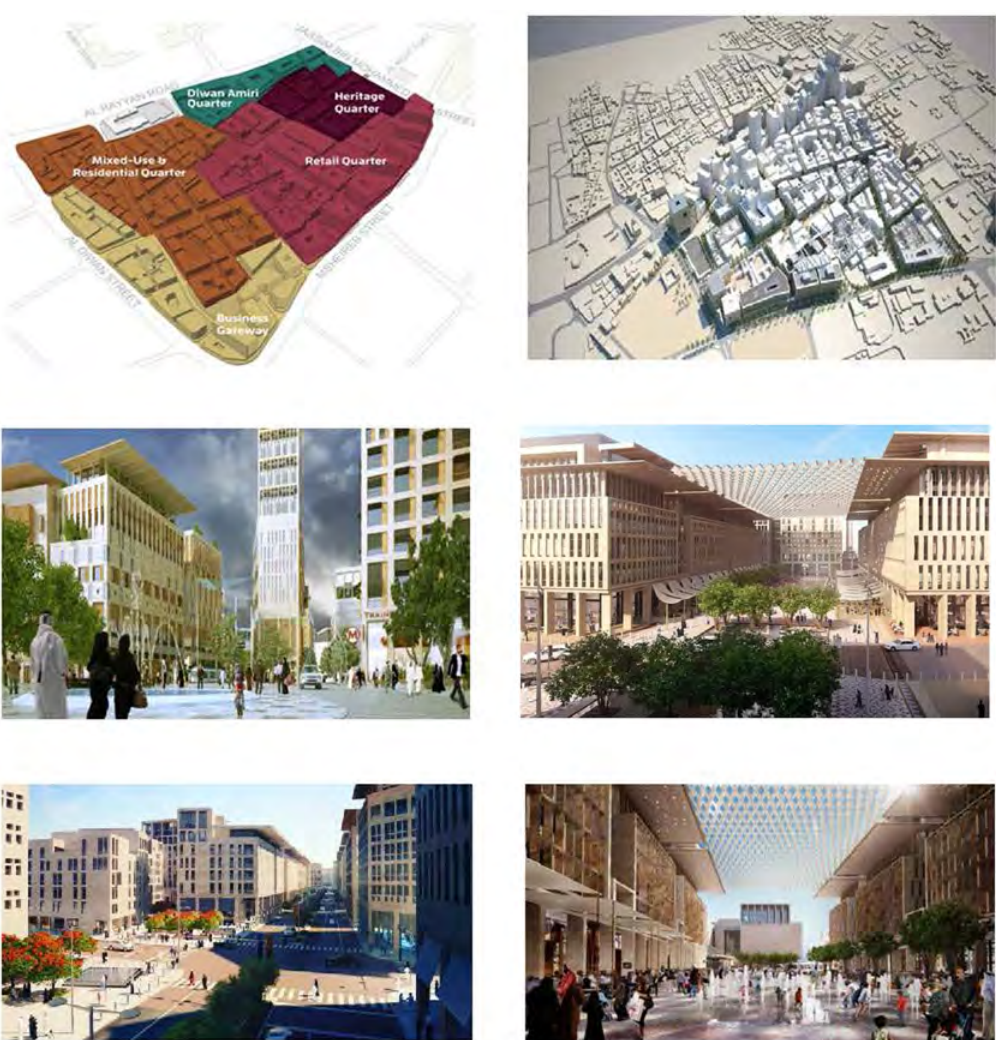
Figure 4. New Urban Identity - Msheireb Project- Doha-